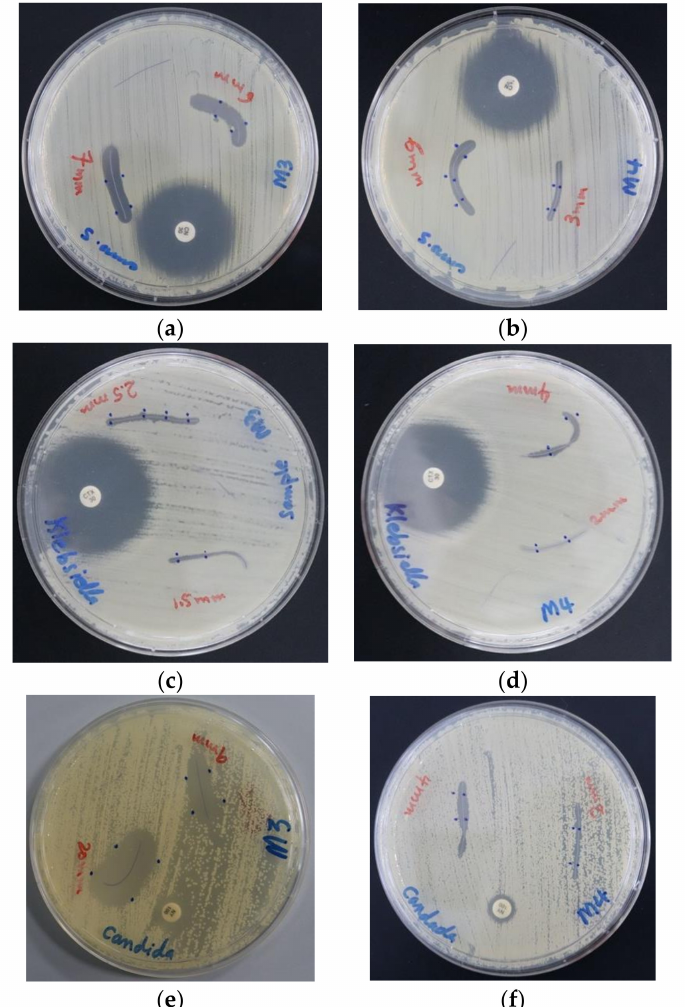
Figure 7. Antimicrobial agar plate methods on dip coated PGA sutures with positive control antibiotics. From left to right: against S. aureus ATCC 25,923 ( a ) AV-PVP-I 2 ; ( b ) AV-PVP-I 2 -NaI; against K. pneumoniae WDCM 00097 ( c ) AV-PVP-I 2 ; ( d ) AV-PVP-I 2 -NaI; against C. albicans WDCM 00054 ( e ) AV-PVP-I 2 ; ( f ) AV-PVP-I 2